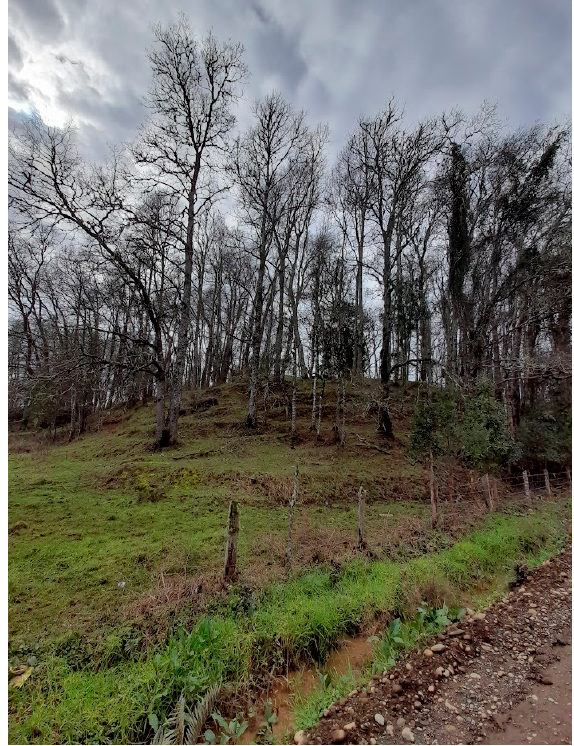
Figure 6. Possible steps on the hill near San Luis del Alba